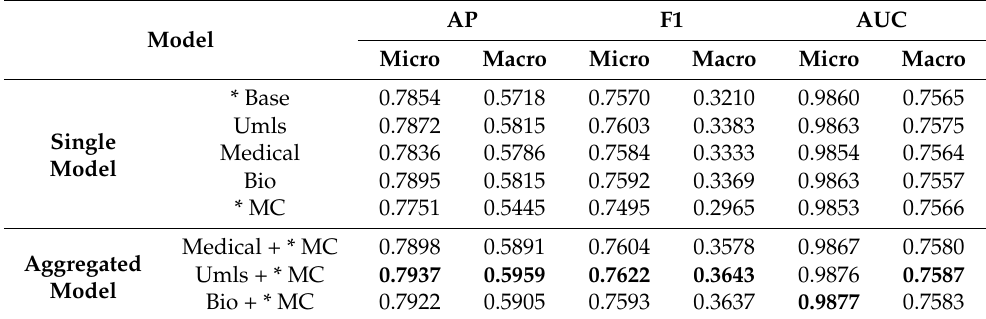
Table 4. Comparison of